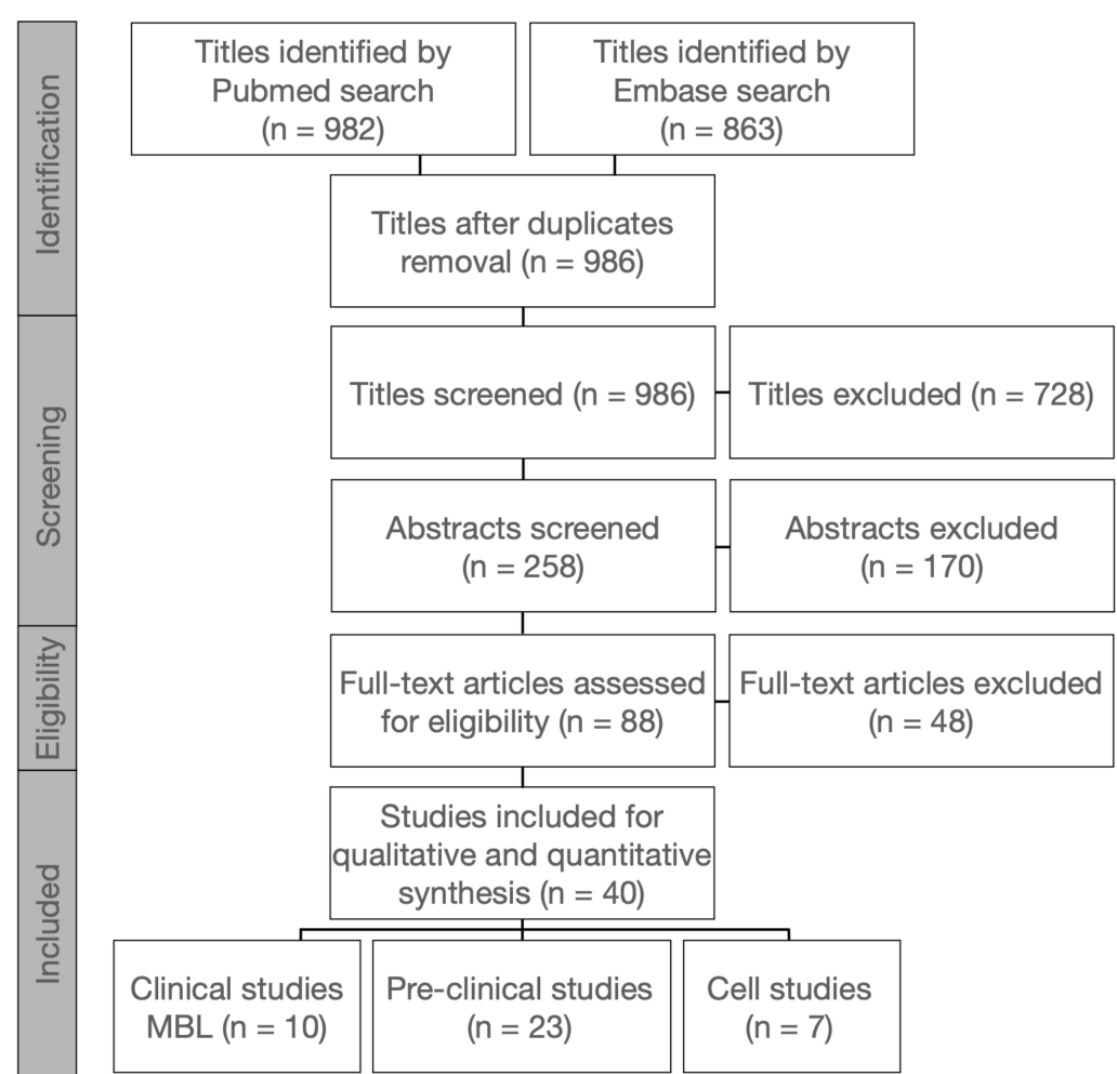
Figure 1. Search strategy and study selection process.